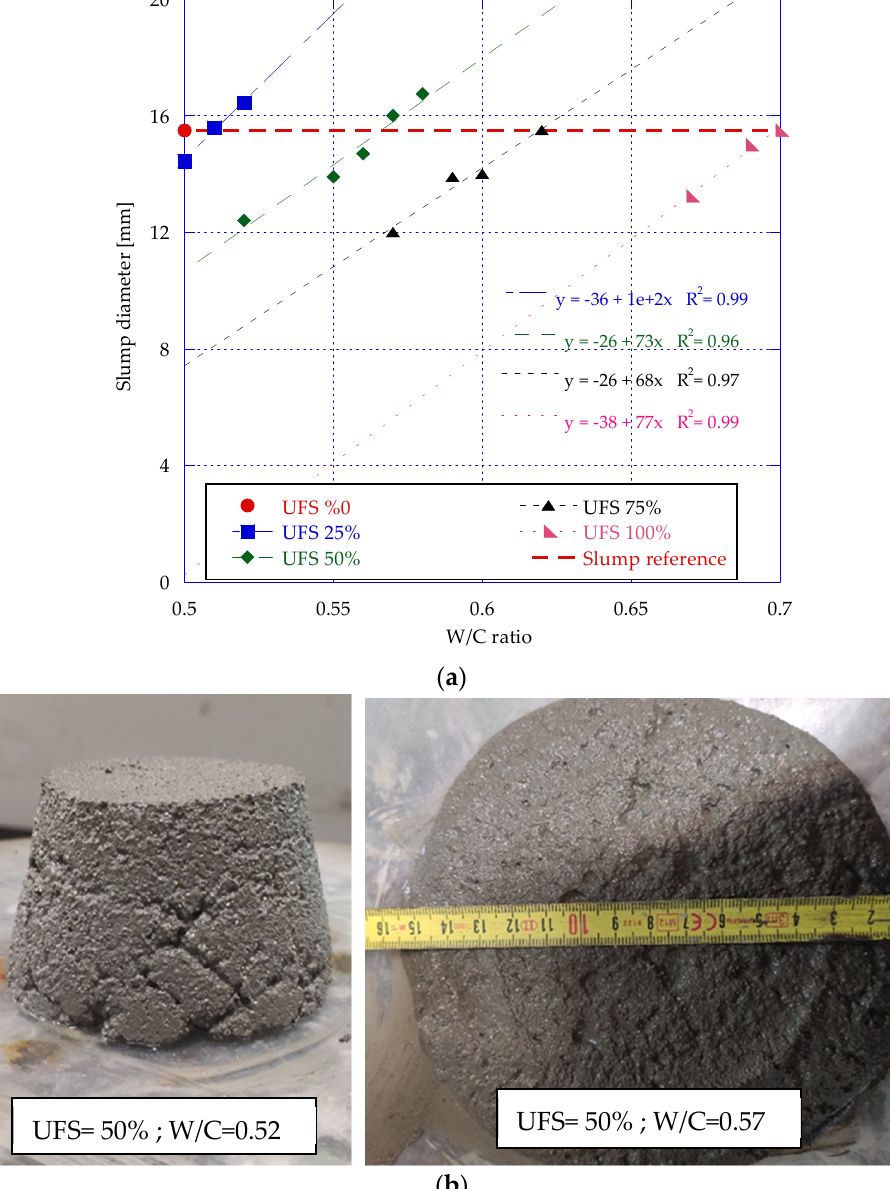
Figure 6. Mortar workability: slump table test results in cm ( a ) and comparative example for a fixed UFS value ( b ).